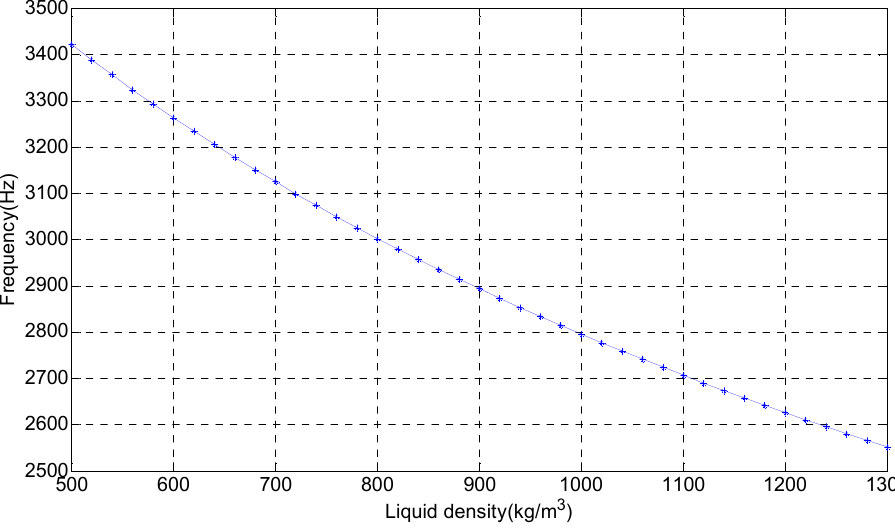
Figure 2. Natural frequency of the tuning fork changes with the liquid